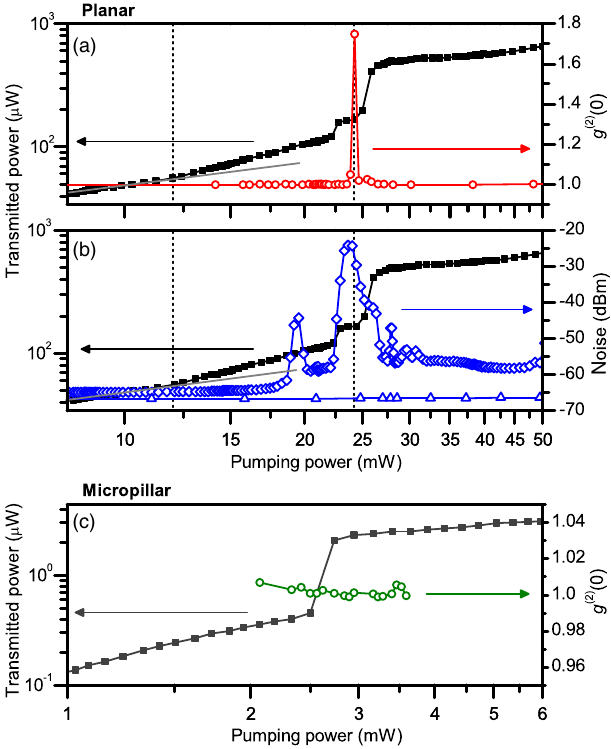
FIG. 5. Power dependence of g ð 2 Þ ð 0 Þ and signal noise. (a) The transmitted power through our planar cavity sample (black squares) andthe correspondingvalueof g ð 2 Þ ð 0 Þ (redcircles) againstpumping power. (b) The measured photocurrent noise of the emitted light (blue diamonds) shown with the shot noise level (blue triangles) and the transmitted power (black squares) against pumping power. Thevertical dotted lines show the two P 1 and P 2 thresholds. (c) The value of g ð 2 Þ ð 0 Þ (green circles) along with transmitted power (gray squares) against pumping power in the micropillar